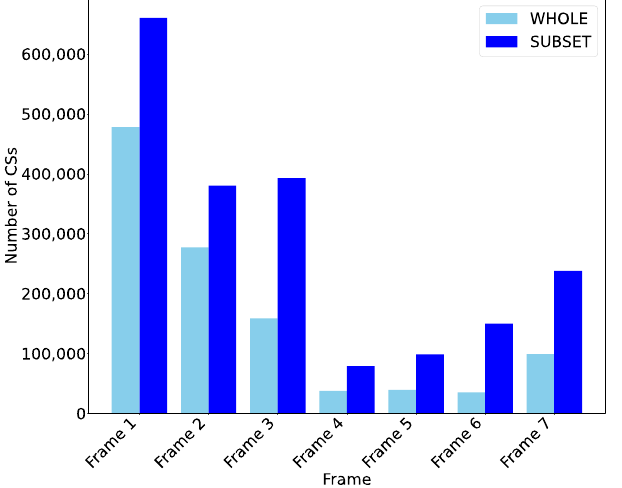
Figure 12. Number of CSs achieved by SUBSET and WHOLE for the seven investigated frames.